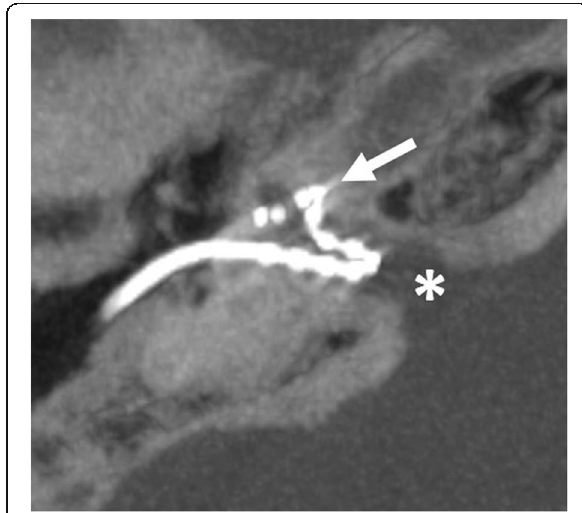
Fig. 32 A 20-year-old male patient, with incomplete partition type III and malposition of the electrode in the internal auditory canal. CBCT paraaxial maximum intensity projection image shows part of the electrode array in the basal turn (arrow), but the rest of the electrode forming a slope within the internal auditory canal